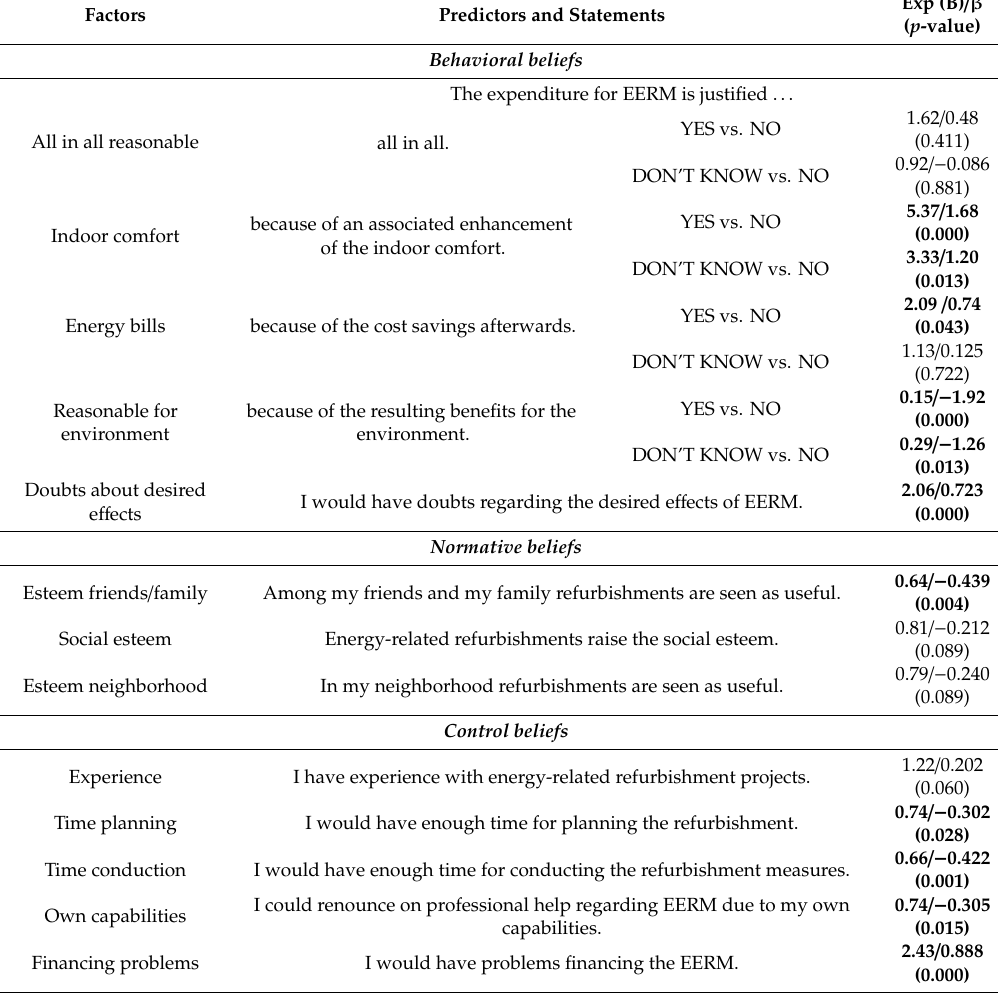
Table 2. Results for the numeric and categorical variables of being a